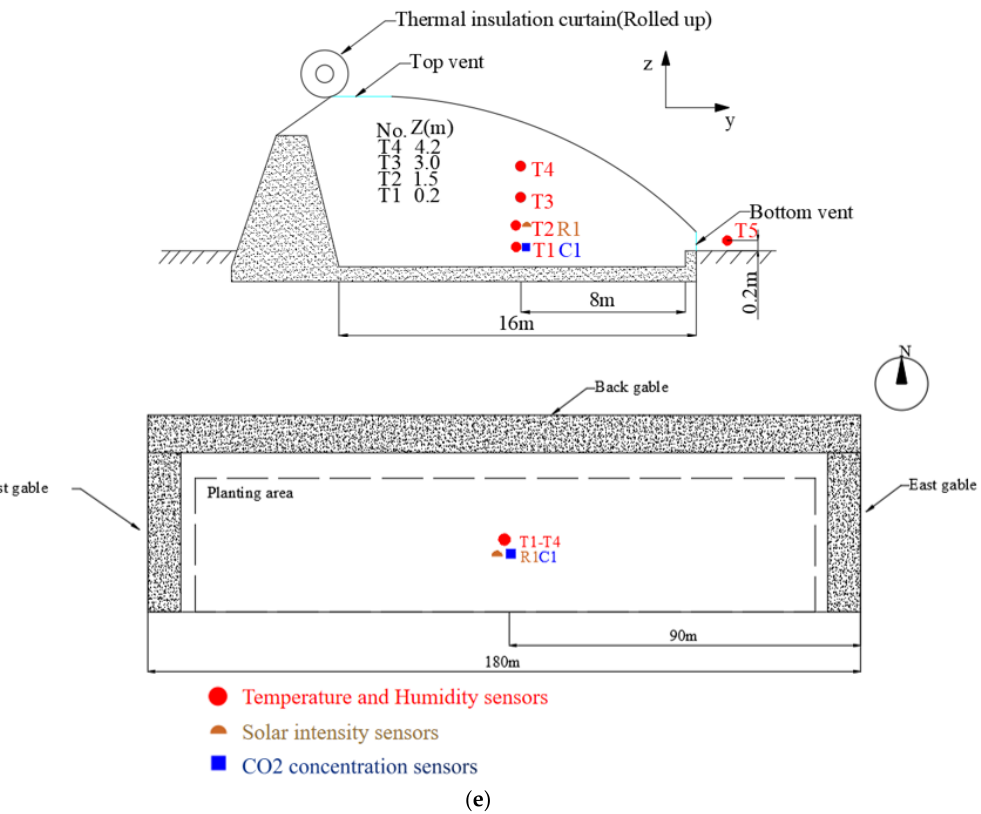
Figure 3. Sensor location in each SSG. ( a ) Sensor location in G1 and G2; ( b ) Sensor location in G3; ( c ) Sensor location in G4; ( d ) Sensor location in G5 – G7; ( e ) Sensor location in G8 and G9.